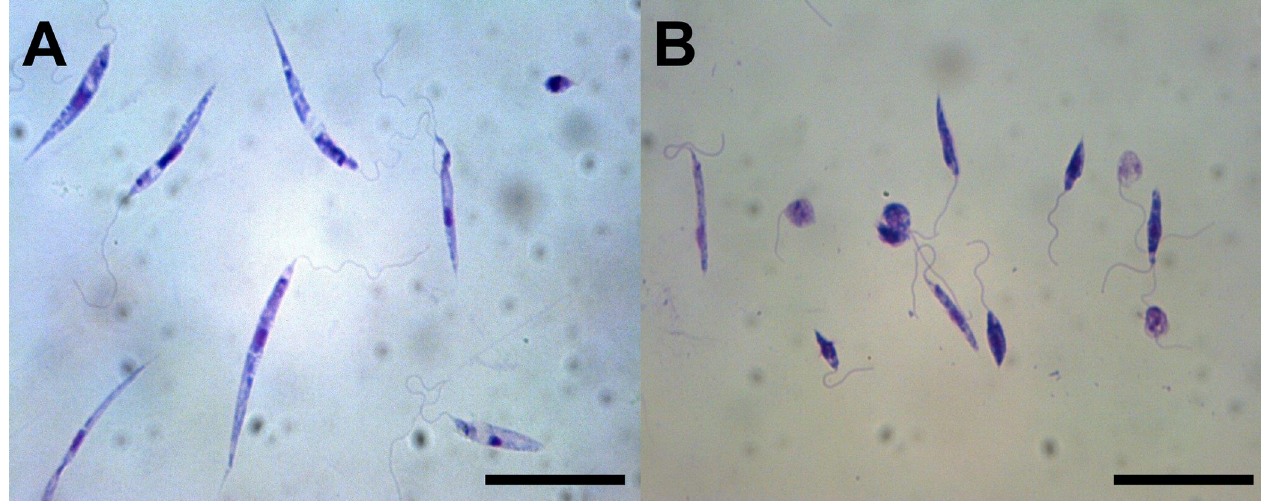
Fig 5. Cultured promastigotes of isolated strains. A) the strain RTAR/IT/21/RI325 isolated from a gecko Tarentola mauritanica , with longer body and flagella. B) the strain ISER/IT/21/SF178 isolated from a sand fly female Sergentomyia minuta . Scale bars A,B) 30 μ m.